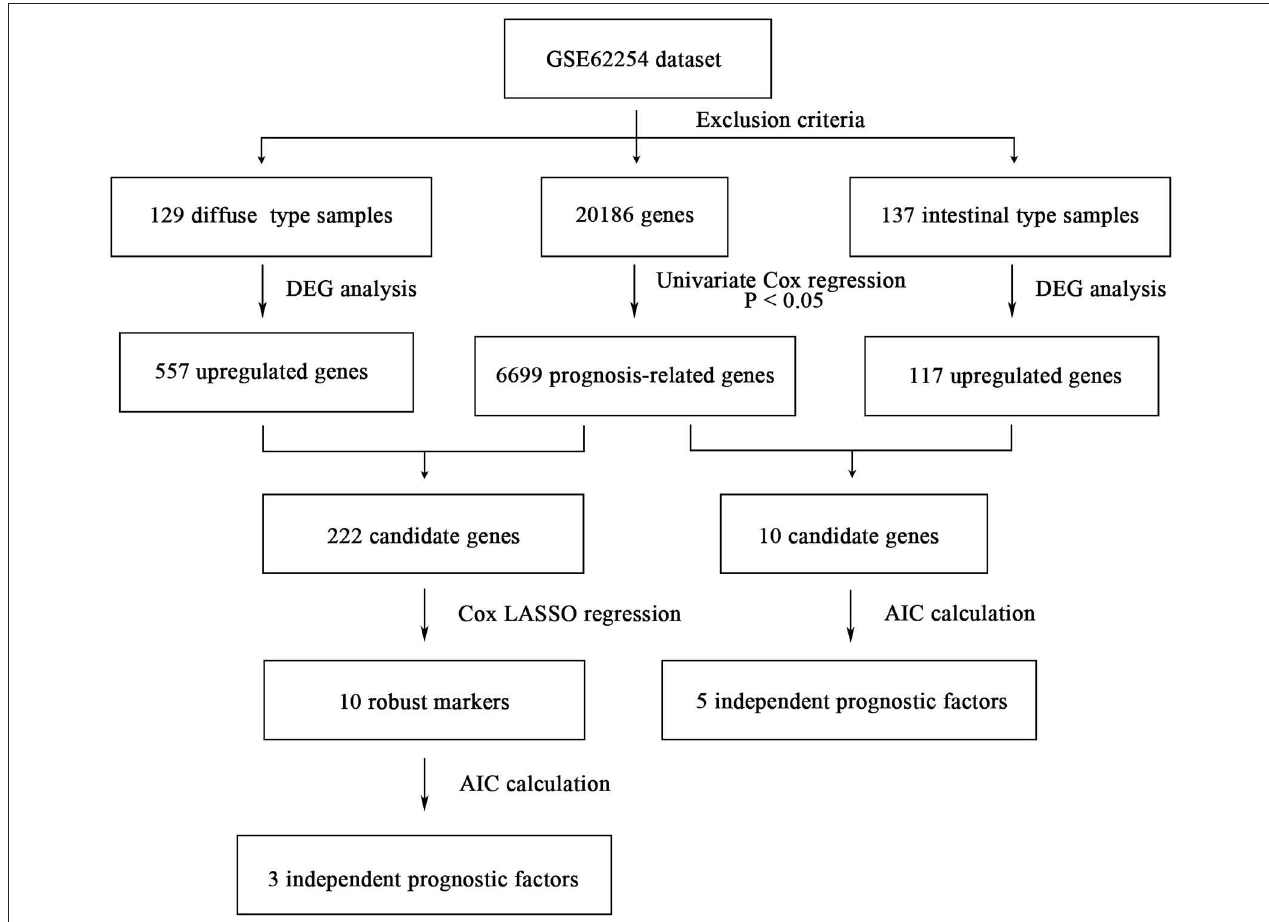
FIGURE 1 | The flowchart of identifying procedure for the multi-gene signatures in intestinal and diffuse type